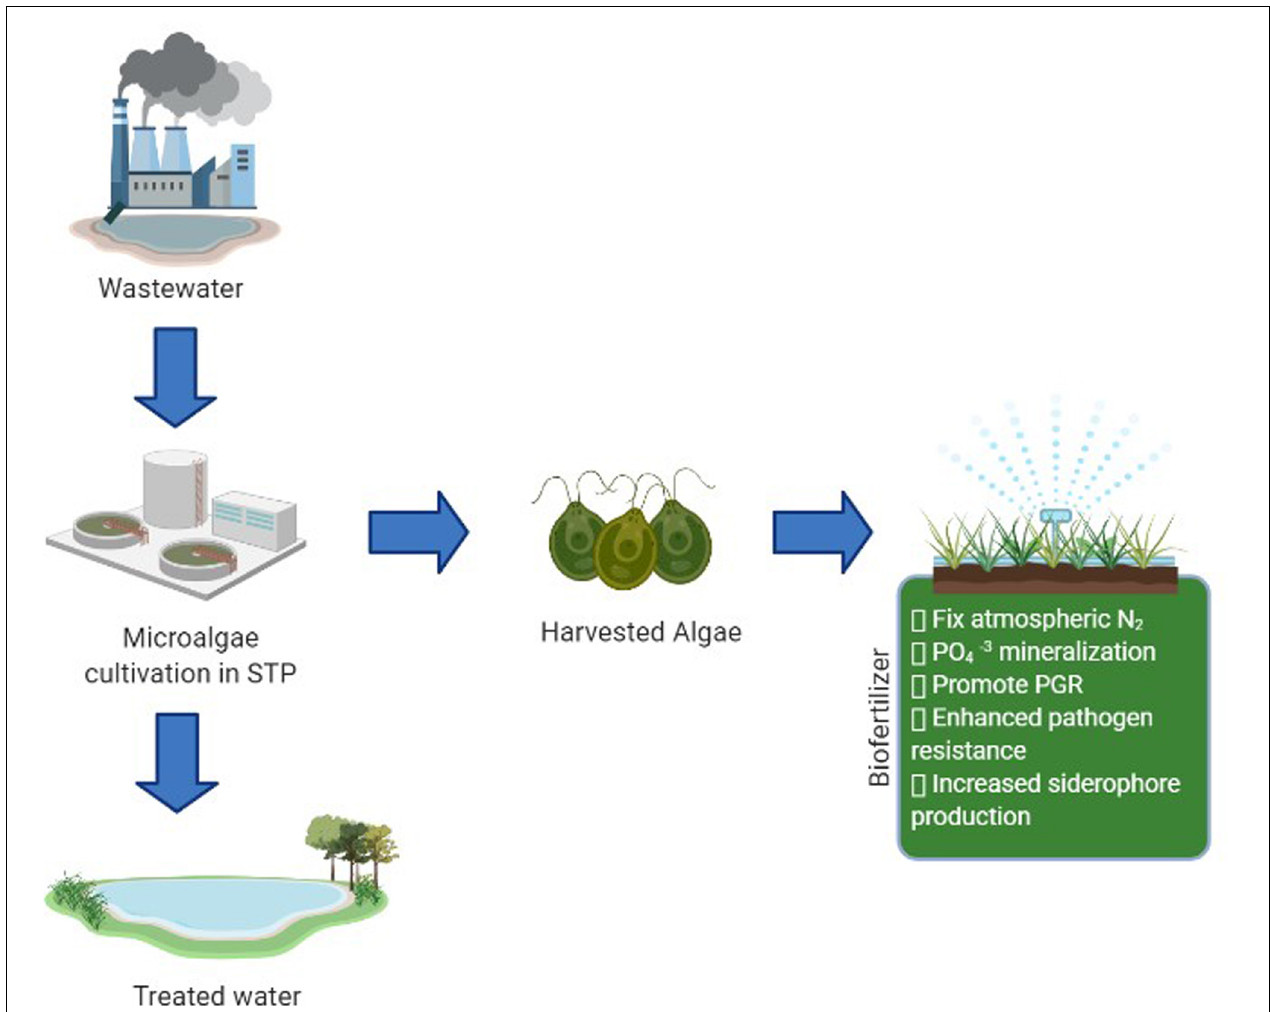
FIGURE 4 | Schematic representation of reclamation of wastewater into a biofertilizer using microalgae (Created with